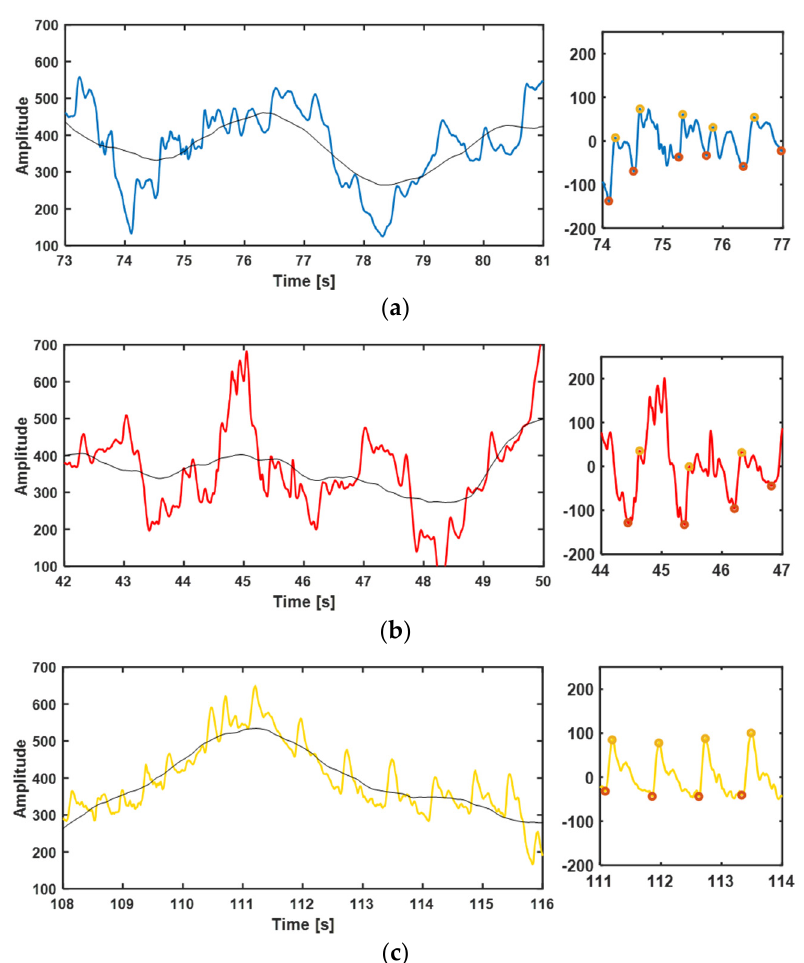
Figure 10. The waveform with disturbance due to arm swing under the three attachment conditions: Overall waveform with baseline (black line) ( left ) and local amplification waveform after removing the baseline ( right ) of ( a ) direct measurement without adhesive; ( b ) measurement with double-sided adhesive and ( c ) measurement with the biomimetic fusion structure